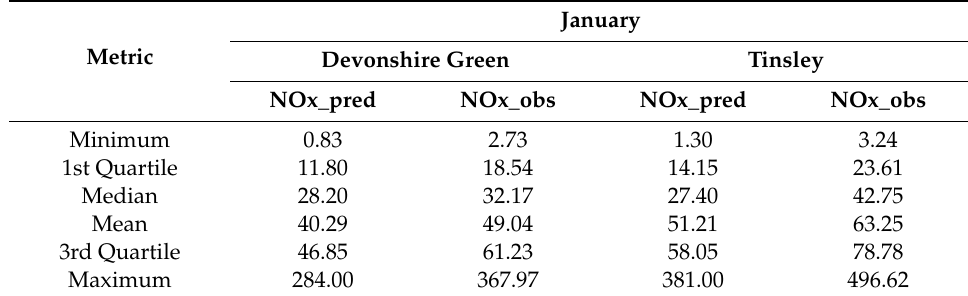
Table 4. Summary of the observed and predicted NOx concentrations ( µ g / m 3 ) in January at Devonshire Green and Tinsley monitoring stations.